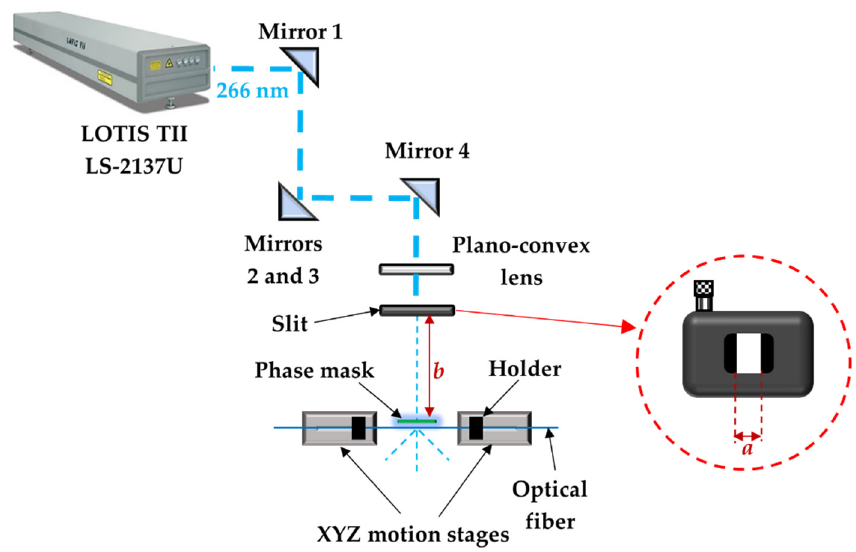
Figure 1. Sketch of the FBG inscription setup ( a and b correspond to the slit width and the distance between the slit and the phase mask, respectively).